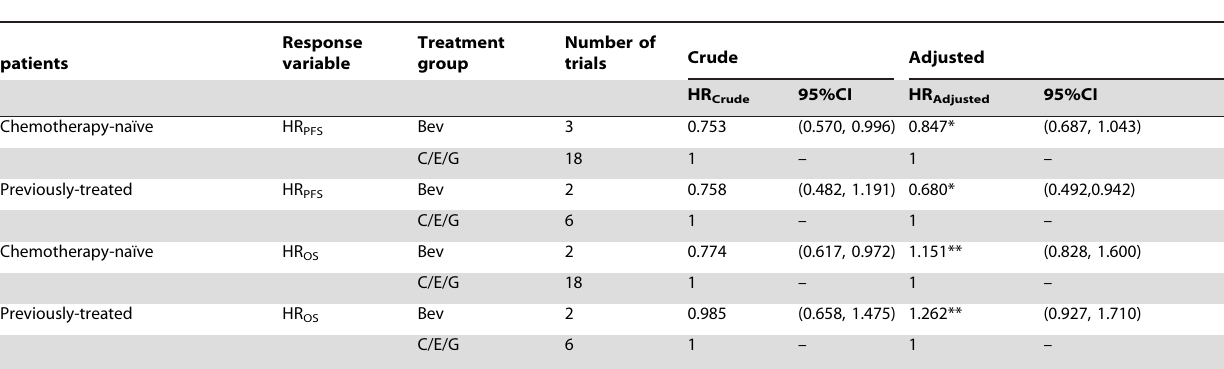
Table 2. Crude and risk-adjusted hazard ratio of BEV comparing to C/E/G.